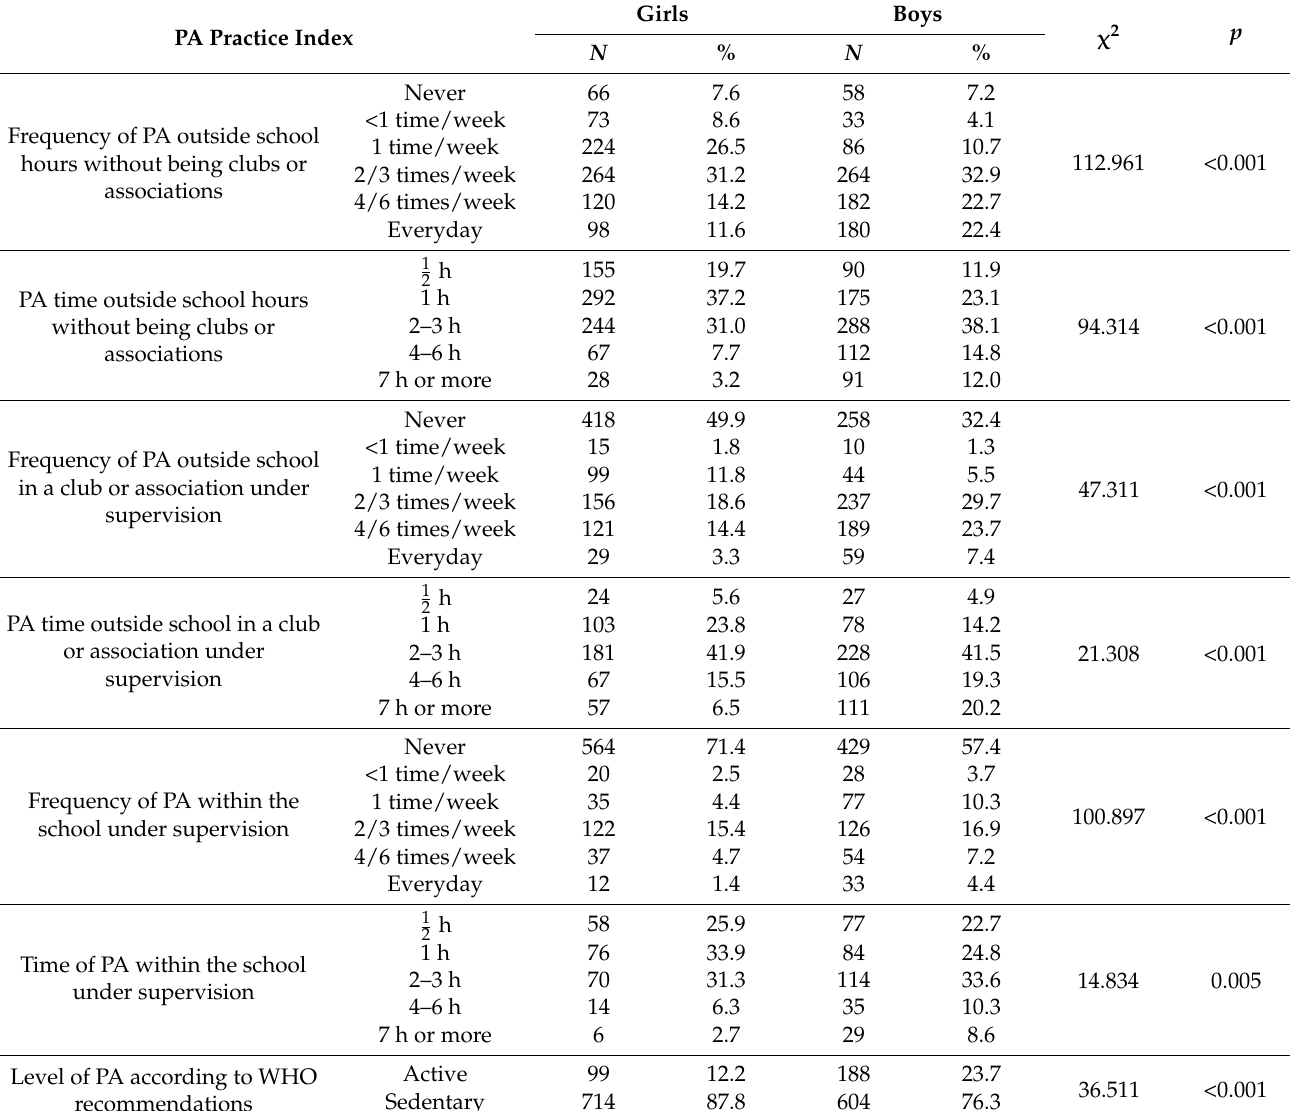
Table 3. Characterisation of adolescents’ physical activity